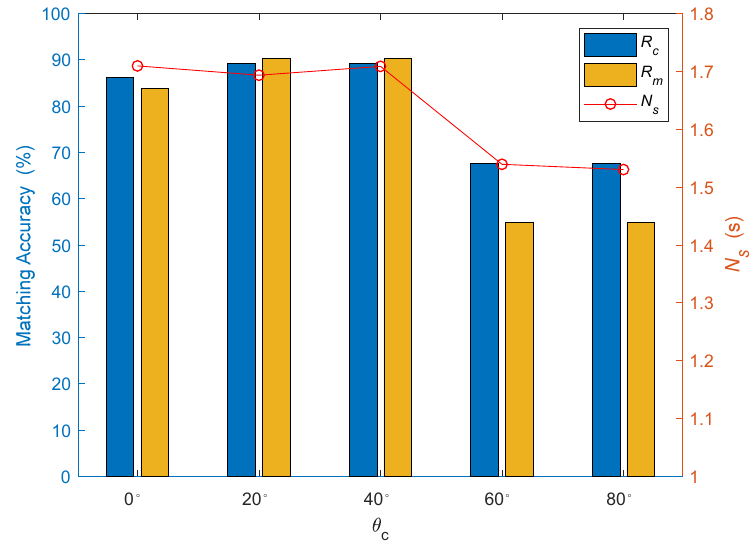
Figure 10. Matching results under different segmentation angles.